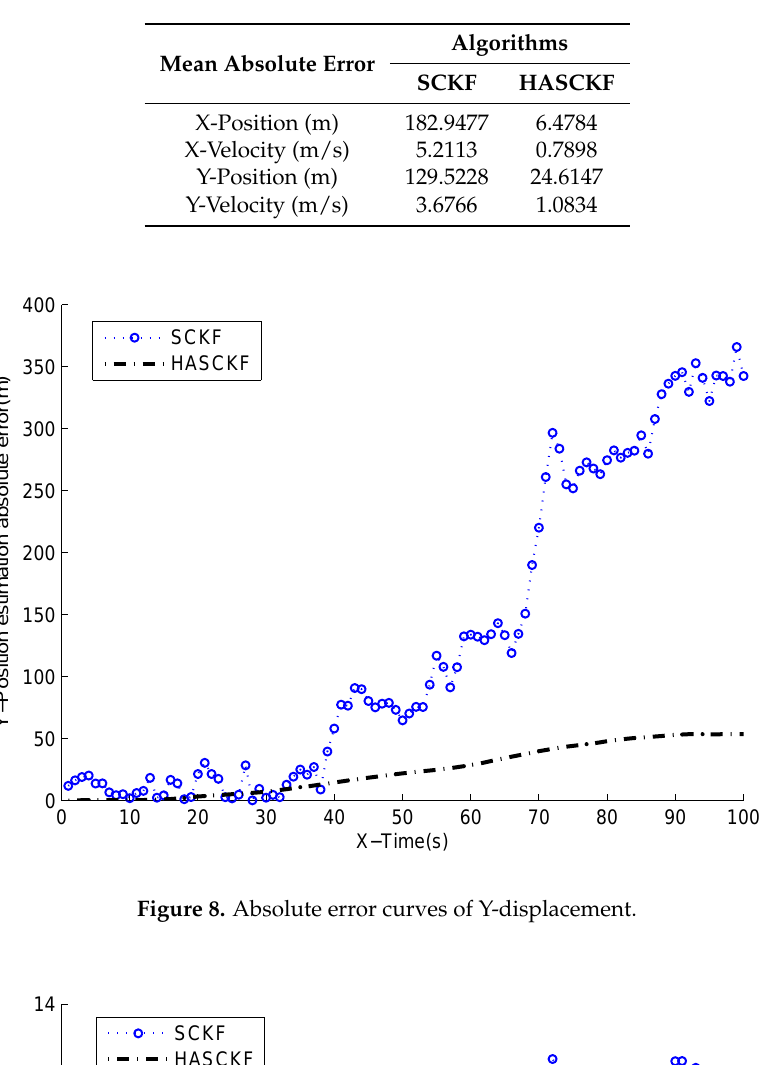
Table 3. The mean absolute error of two algorithms.